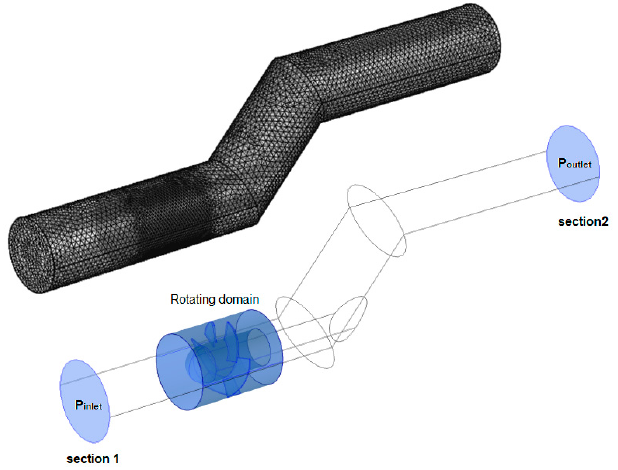
Figure 3. Mesh domain and boundary conditions assignment. Figure 4. Mesh domain and boundary conditions assignment.